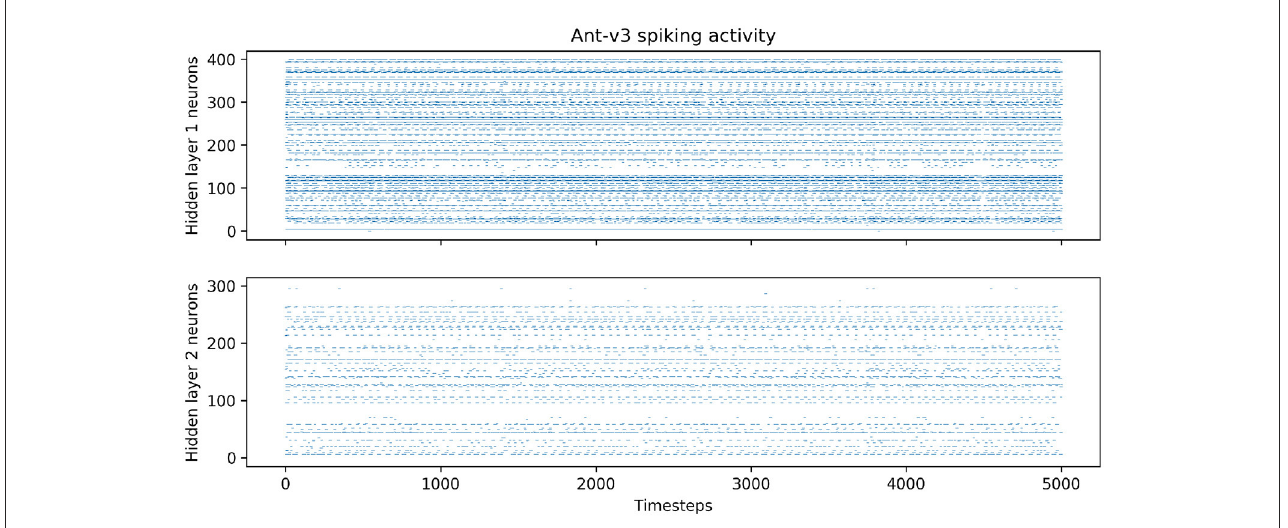
FIGURE6 Spiking activity in the both hidden layers during one Ant-v3 episode. The x-axis shows the total number of time steps (1,000 environment time steps multiplied by five SNN time steps for each observation).